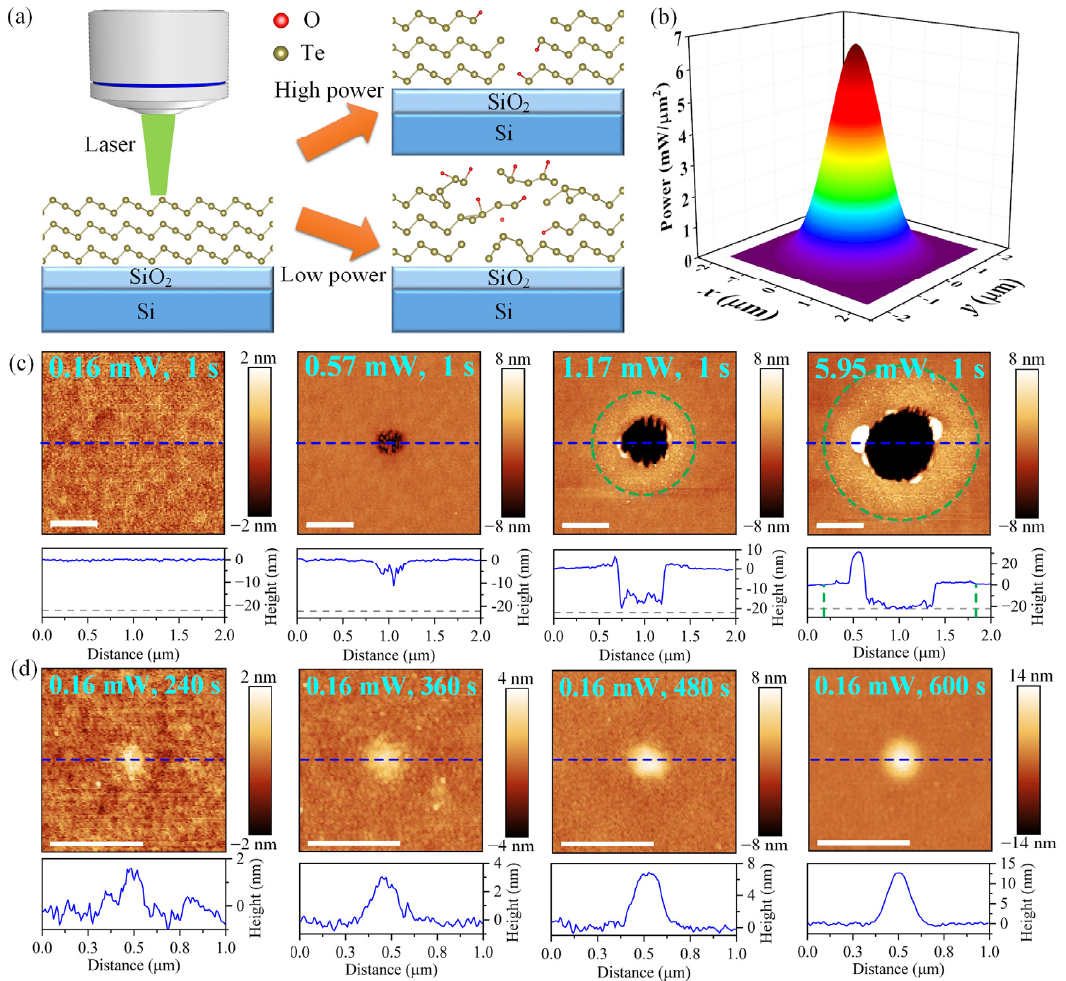
Figure 2. Modification of the Te flake irradiated by laser with different power and time. ( a ) Schematic of the laser irradiation process; ( b ) schematic of the laser beam with Gaussian distribution of power density; AFM images (top inset images) of Te nano-flakes irradiated by laser with different power ( c ) and time ( d ) and the corresponding height profiles (bottom inset images, the positions are shown by the blue dash lines in the top inset images, the gray dotted lines indicate the thickness of the flake, the green dotted circles indicate the laser irradiation area), scale bar is 500 nm.